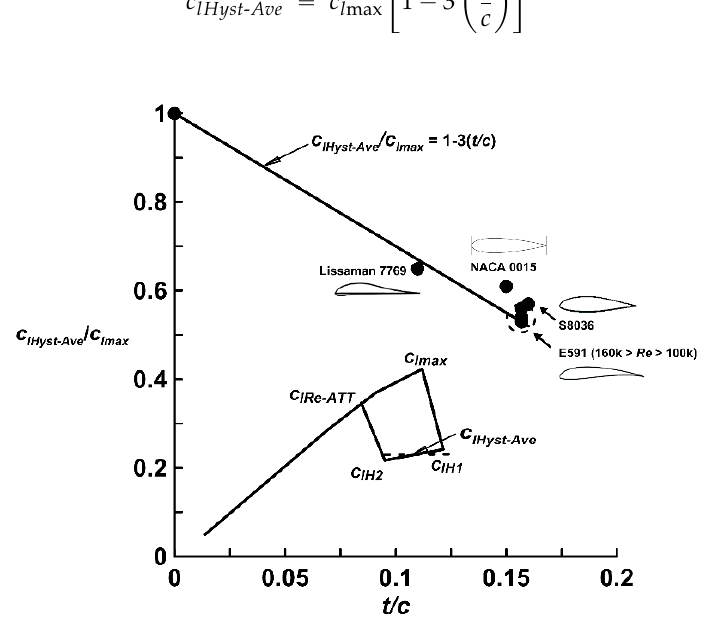
Figure 2. Effect of thickness on average lift ratio during the return stroke.